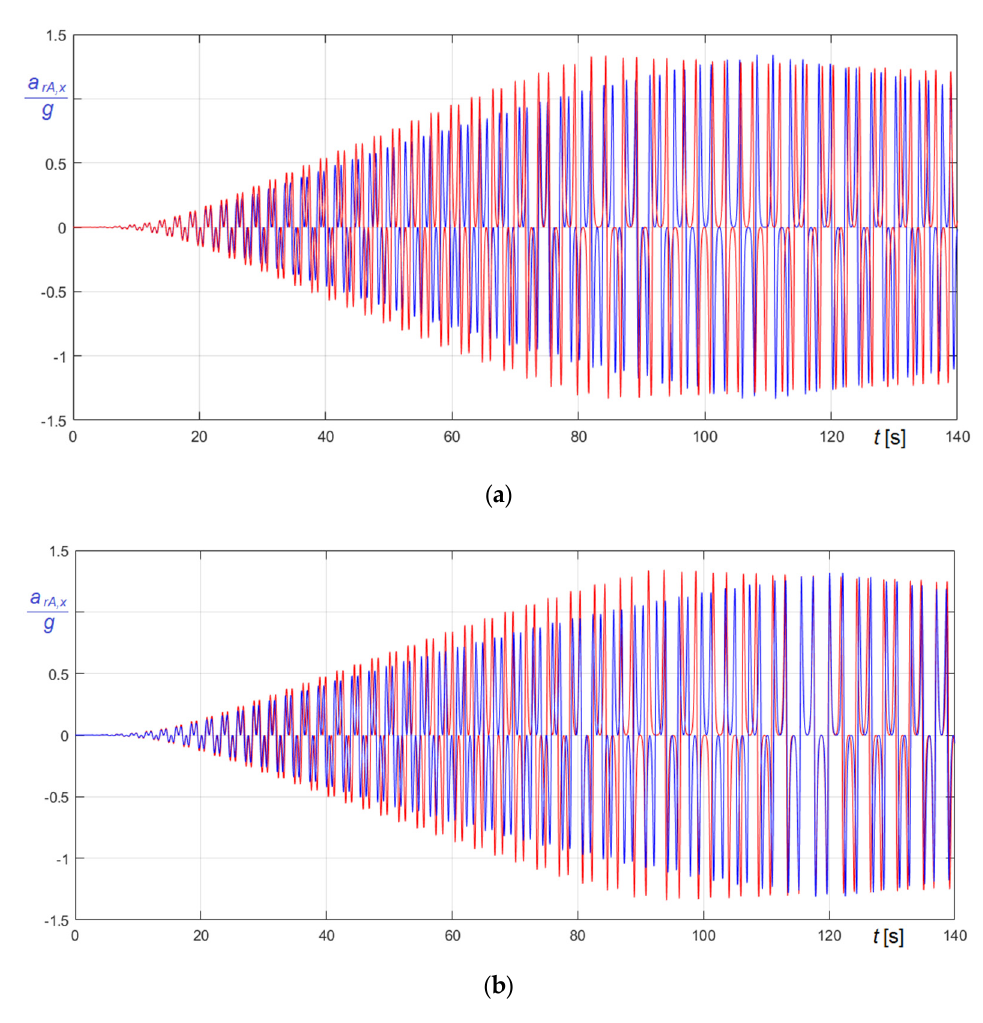
(cid:3028) (cid:3293)(cid:3250),(cid:3299) − (cid:1872) curves in (cid:1827) in the transient phase (red curves in the undamped − t curves in A in the transient phase (red curves in the undamped case, Figure 24. Comparison of Figure 24. Comparison of a rA , x (cid:3034) g blue curves in the damped case): ( a ) M e 1 forcing function (Equation (74)); ( b ) M e 2 forcing function case, blue curves in the damped case): ( a ) (cid:1839) (cid:3032)(cid:2869) forcing function (Equation (74)); ( b ) (cid:1839) (cid:3032)(cid:2870) forcing (Equation function (Equation (75)).